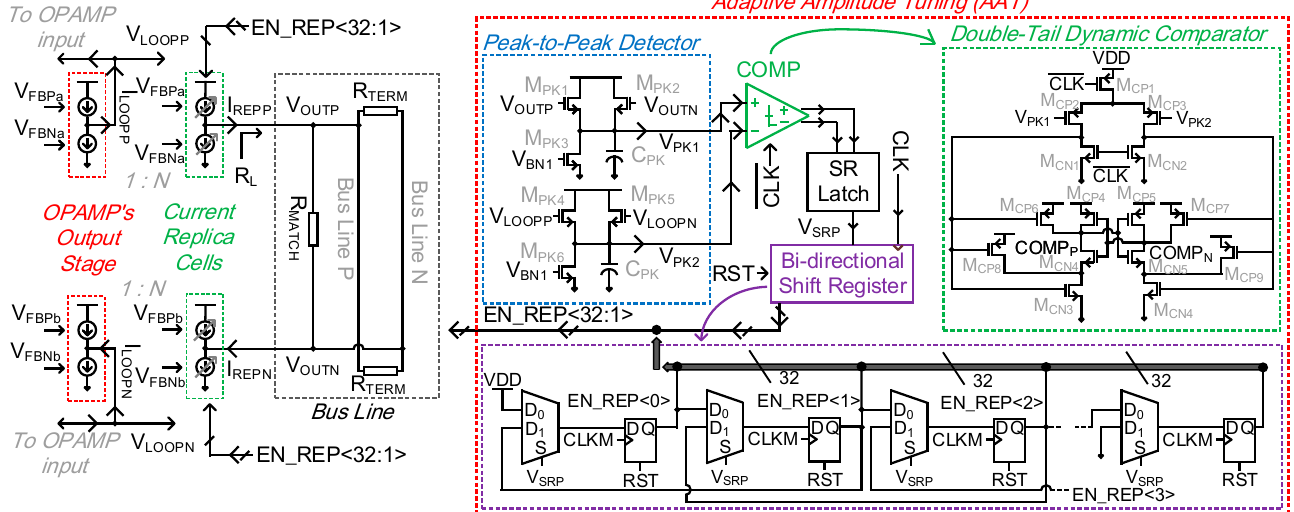
comparably negligible in Equation (2). The unity-gain property not only mitigates the